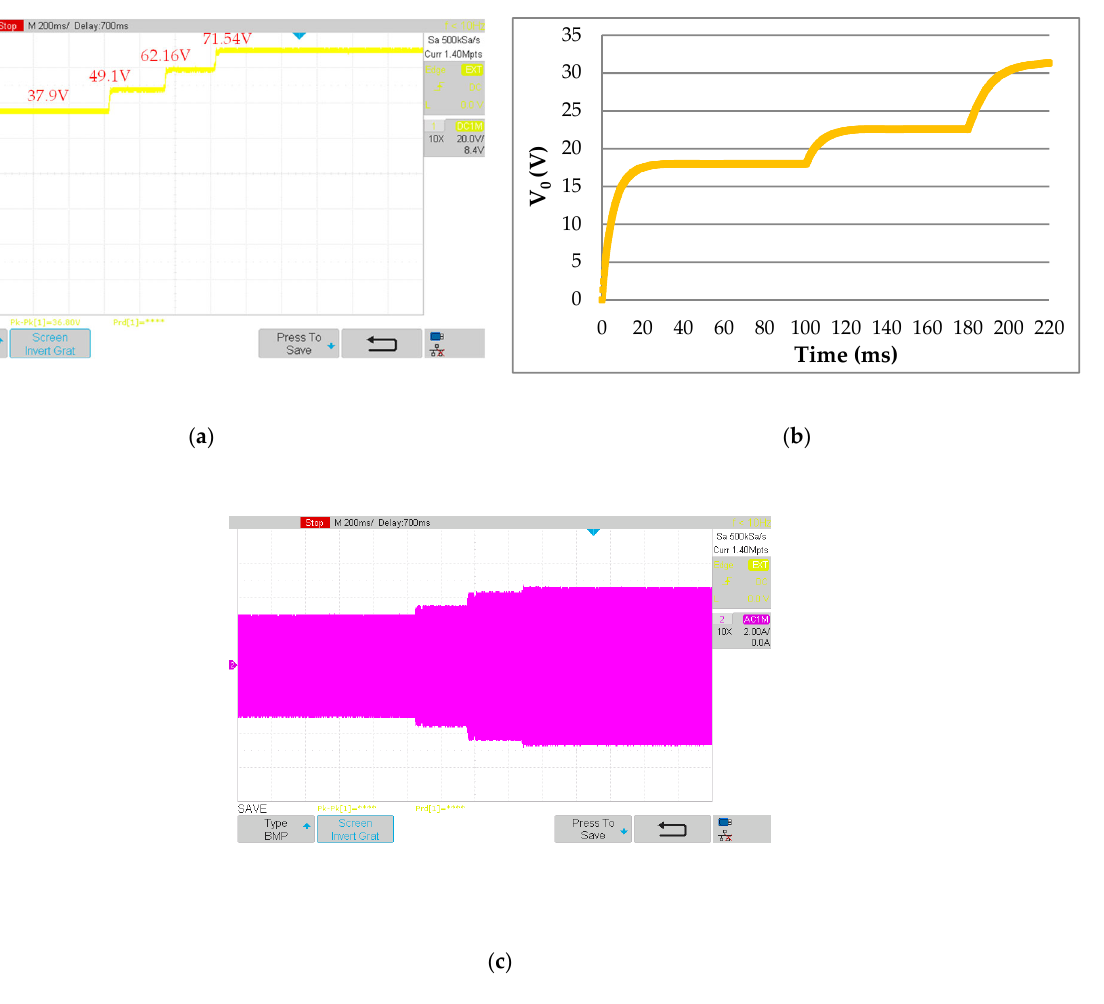
Figure 8. ( a ) measured V O ; ( b ) simulated V O ; ( c ) measured I P when R L is 16 Ω , 22 Ω , 28 Ω , and 32 Ω , respectively.